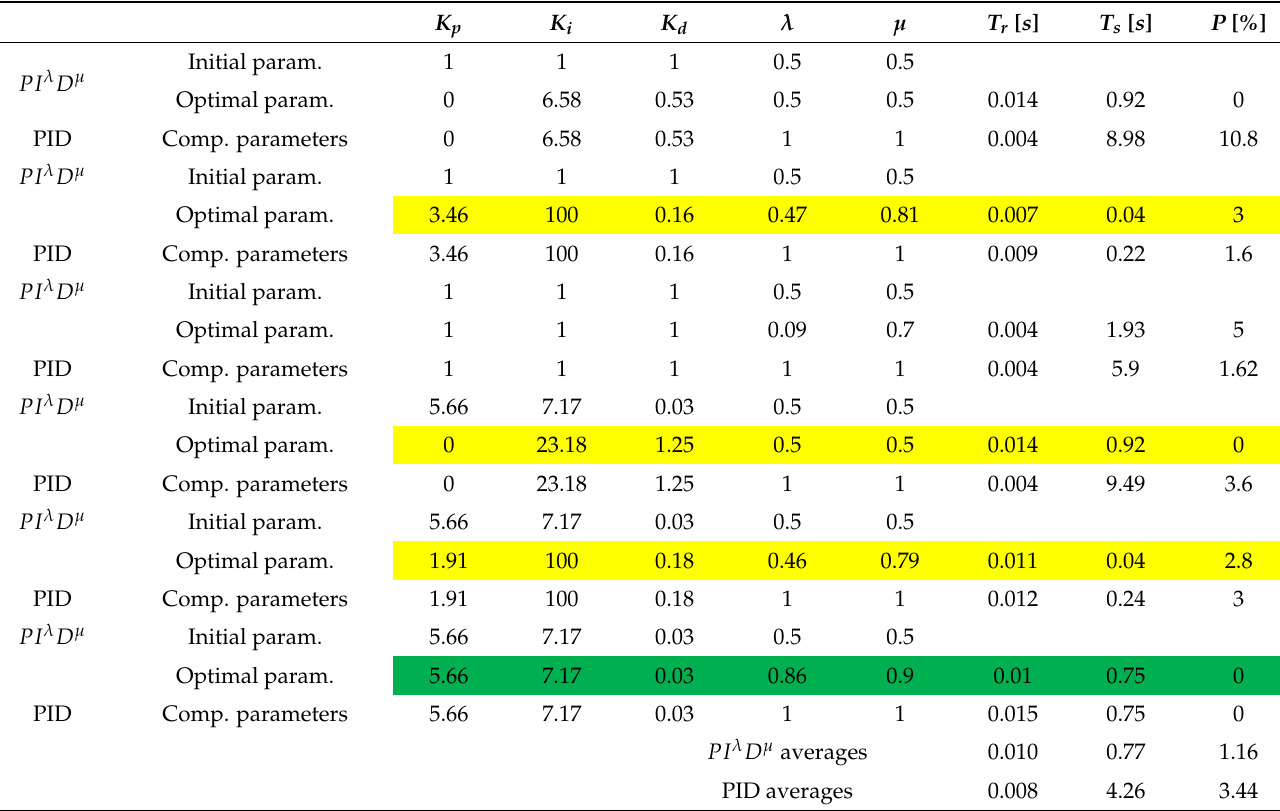
Table 1. Initial, optimal, and comparing parameters of the PI λ D µ and PID and their step responses in the Laplace domain. K p K i K d